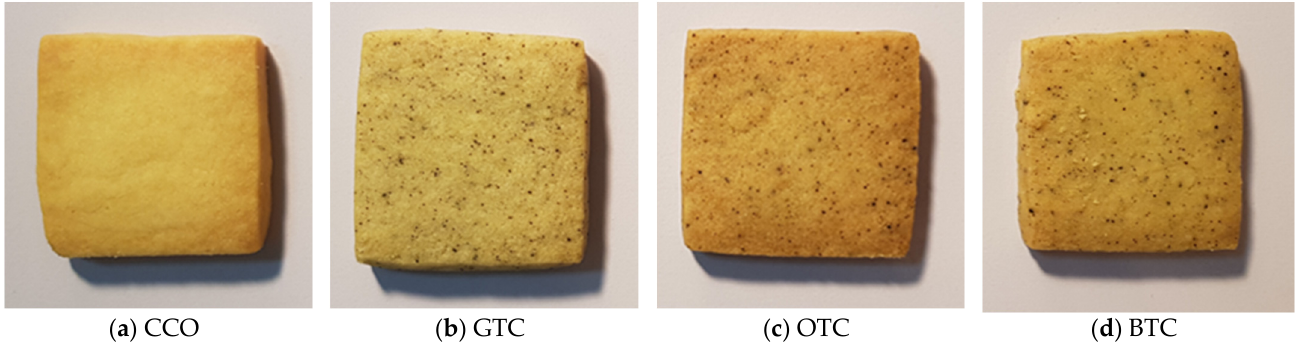
Figure 1. Non-gluten shortbread cookies with various spent tea leaf powders: ( a ) control non-gluten shortbread cookies without spent tea leaves powder (CCO), ( b ) non-gluten shortbread cookies with spent green tea leaves powder (GTC), ( c ) non-gluten shortbread cookies with spent oolong tea leaves powder (OTC), and ( d ) non-gluten shortbread cookies with spent black tea leaves powder (BTC).